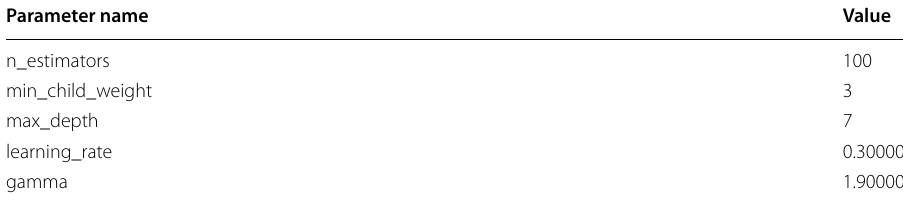
Table 86 Modes of XGBoost tuned hyperparameter values for experiments with the data exfiltration dataset